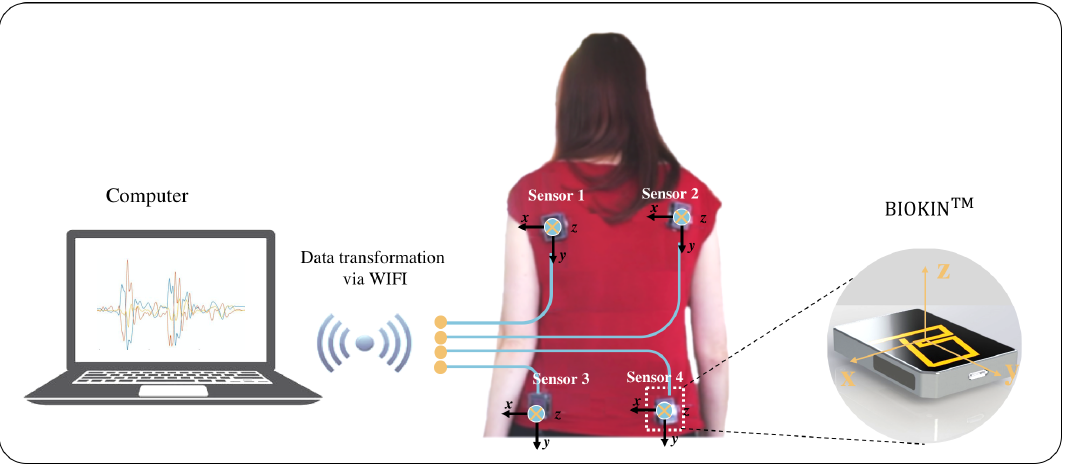
Figure 1. Experiment setup: Four BioKin TM sensors are attached on the back, connected to computer via wifi.